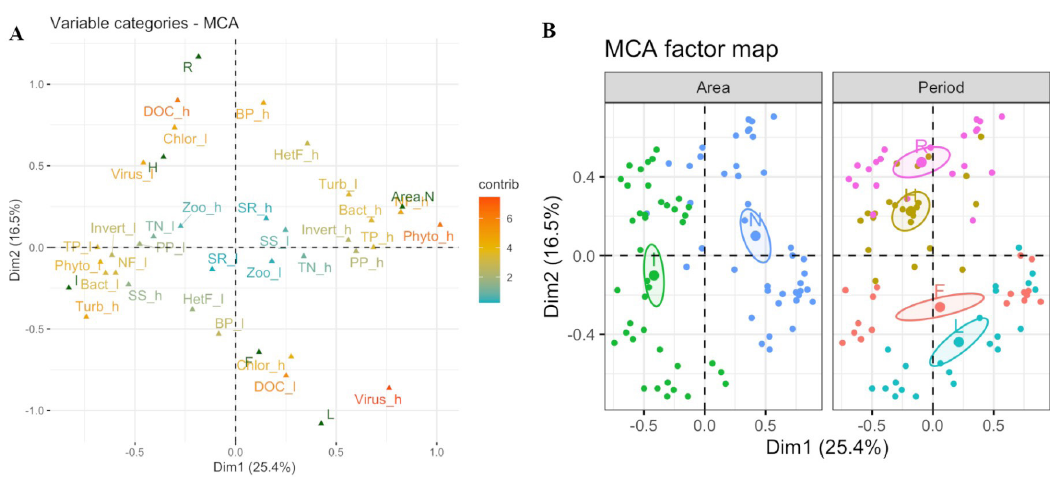
Figure 7. Multiple correspondence analysis (MCA) of limnological characteristics of Batata Lake along with the monitoring program. (A) MCA plot. Limnological characteristics were categorized as l - low and h – high. Dark green symbols represent Area: N = natural area, I – impacted area, and Flood pulse phase: H – high-water, F – falling water, L – low-water, R – rising water. Colored symbols are Bact – bacterioplankton abundance; Virus – viroplankton abundance; HF – heterotrophic flagellates abundance; Phyto – phytoplankton abundance; Zoo – zooplankton abundance; Invert – macroinvertebrates abundance; Fish – fish abundance; Igapo – igapó forest abundance; BP – bacterial production rate; PP – primary production rate; Chlor – Chlorophyll a concentration in the water; Turb – turbidity; SS – suspended solids; SR – species richness; TN – total nitrogen; TP – total phosphorus; DOC – dissolved organic carbon; NF – nitrogen fixation. The letters l and h stand for l -low and h – high. (B) MCA data is sorted according to the categorical variables Area (N – natural, I – impacted) and Flood pulse phase (H – R – rising water, high-water, F – falling water, L –